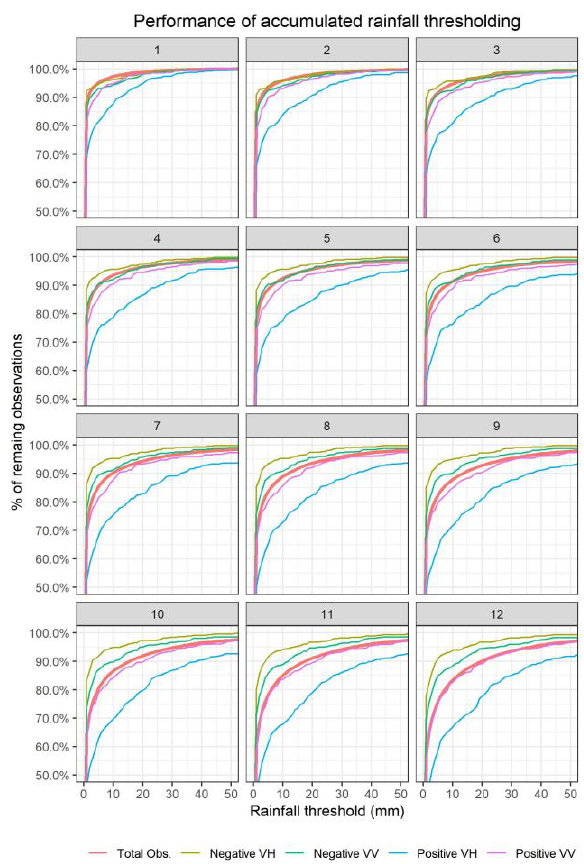
Figure 5: Results of SAR observation masking based on accumulated rain. Every chart corresponds to the number of hours before SAR acquisition that are being considered for precipitation summation. Thresholds are represented in the horizontal axis, while the vertical axis represents the percentage of total and anomalous observations that were preserved after masking.